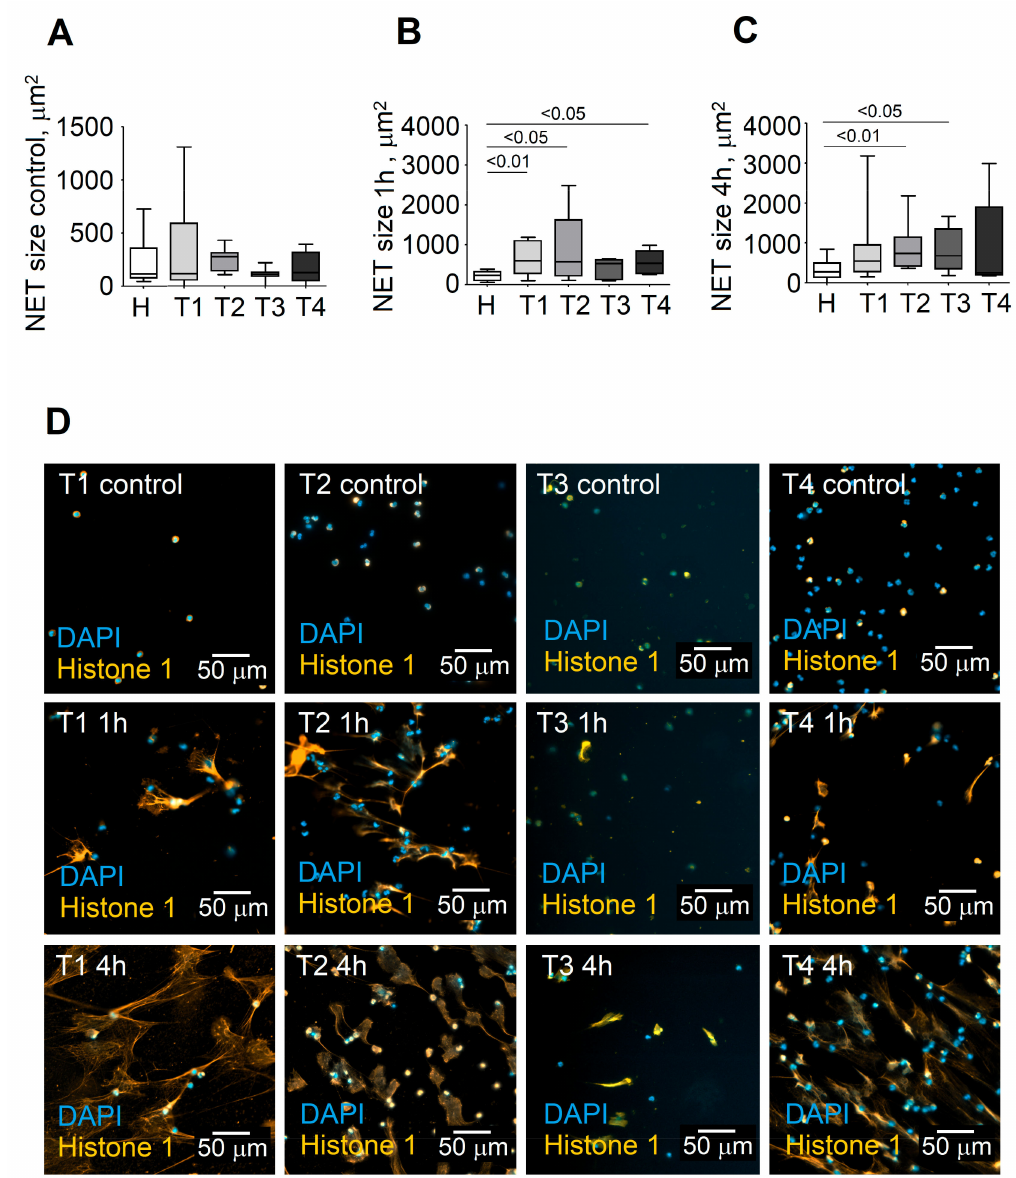
Figure 2. Neutrophils from early T stages of HNC release NETs significantly faster and to a greater extent. ( A ) Quantification of spontaneous NET release in healthy and HNC in di ff erent stages of disease. ( B ) Quantification of early NET release in healthy and HNC in di ff erent stages. ( C ) Quantification of late NET release in healthy and HNC in di ff erent stages. Neutrophils were isolated and stained (control, A ), or co-cultured with P. aeruginosa for 1 ( B ) or for 4 ( C ) h; H—healthy. For comparisons of multiple groups, Kruskal–Wallis ANOVA with Bonferroni correction was used, and for comparisons of two independent groups, Mann–Whitney U-tests were used. Data are shown as median, interquartile range, and minimal and maximal values. ( D ) Exemplified pictures for NET formation in di ff erent HNC T stages. Isolated neutrophils were incubated with control medium or P. aeruginosa for 1 and 4 h, fixed, and stained with DAPI (blue) and anti-histone-1 antibodies (yellow); scale bar 50 µ